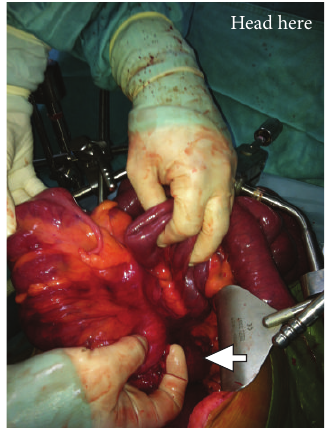
Figure 1: Preoperative abdominal X-ray film. Dilated loops of small abdomen in the upper abdomen. Dilated cecum or massively dilated small bowel loop in right lower abdomen (hollow arrow). Fetal bony silhouette is outlined with solid arrows.